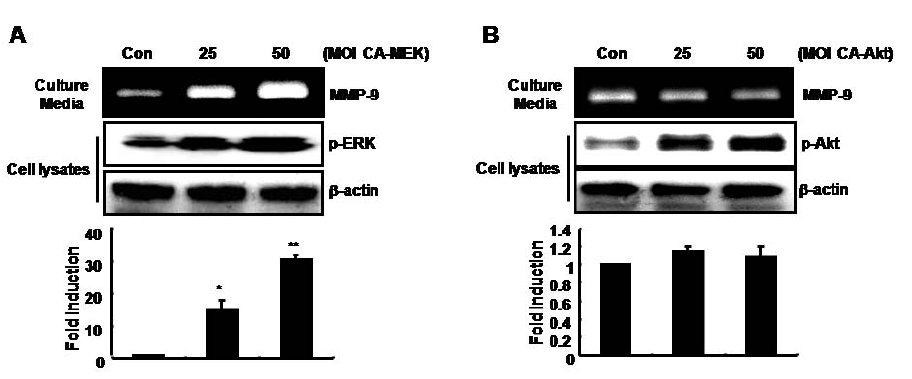
Figure 4. TPA-induced MMP-9 expression is increased by Ad-CA-MEK, but not by Ad- CA-Akt, in SNU216 gastric cancer cells. After Ad-CA-MEK (A) and CA-Akt (B) transfection for 24 h, cells were incubated in serum-free media for 24 h and then fresh serum-free media was added for 24 h. MMP-9 protein expression was analyzed in culture media by zymography. Using the cell lysates, the phosphorylation of ERK (A) and Akt (B) was analyzed by Western blotting. These results are representative of three independent experiments. The values shown are the mean ± SEM. * P < 0.05, ** P < 0.01 vs . control. Con;